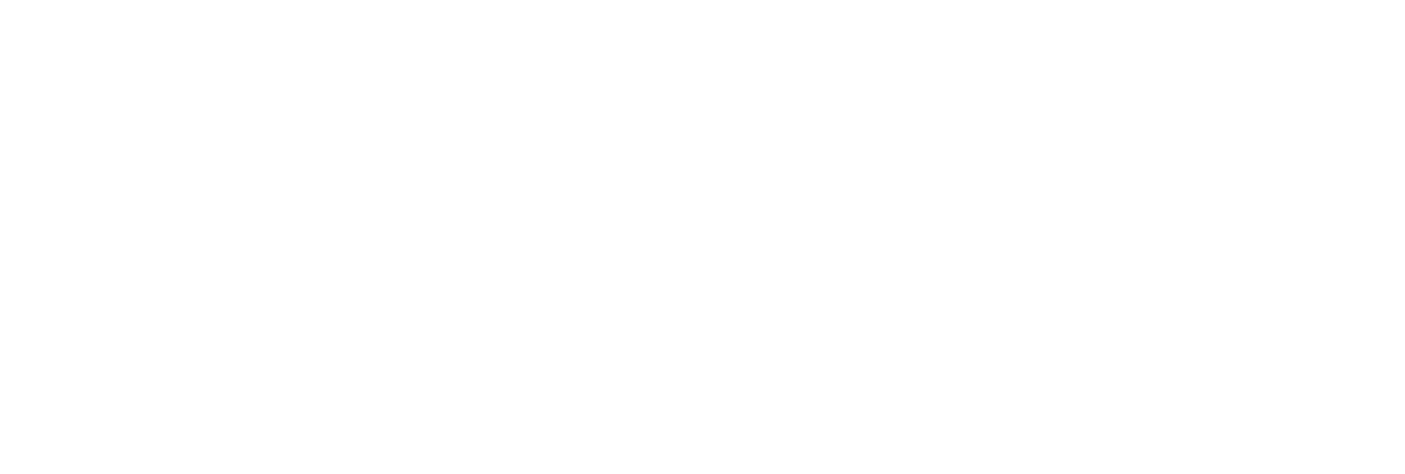
Lang oppholdelsestid for ivermectin i reinmøkk på beite Møkk fra grupper av reinkalver behandlet med ivermectin gjennom munnen eller ved injeksjon, innsamlet over de første ni dagene etter behandling, samt møkk fra ubehandlete kalver, ble fordelt på 1 m x 1 m prøveruter på to typer av skogkledd reinbeite i nord-Finland gjennom vintrene 2001 og 2002. Ubeitete prøveruter var på område som hadde vært avstengt med gjerde til hinder for rein gjennom de siste seks årene før forsøksoppstart. Beitete prøveruter var på område som hadde vært kraftig beitet av rein gjennom de siste fem årene før forsøksoppstart. Vegetasjonen på de to områdene skilte seg fra hverandre ved at det var reinlav (Cladina spp.) på Ubeitet område og ikke på Beitet område. Etter forsøksoppstart ble rein og større vilt holdt borte fra områdene med gjerde. Prøve (utstemplet 10 cm x 10 cm x 5 cm) fra toppen av prøveruter (reinmøkk, vegetasjon og jord) ble tatt månedlig gjennom hver sommer de to påfølgende årene, over en periode som strakte seg fra 24 til 94 uker etter etablering av prøveruter. Prøvene ble analysert for ivermectin ved HPLC - høytrykks- væske-kromatografi. Selv om det var rask nedbryting av ivermectin gjennom den første våren, kunne gjennomsnittskonsentrasjon større enn 55 ng/g tørrvekt måles gjennom hele perioden på mer enn 90 uker etter utlegging av møkk på